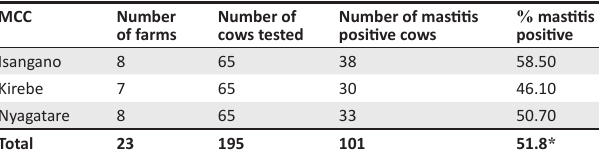
TABLE 4: Mastitis prevalence in relation to cow dirtiness scores.